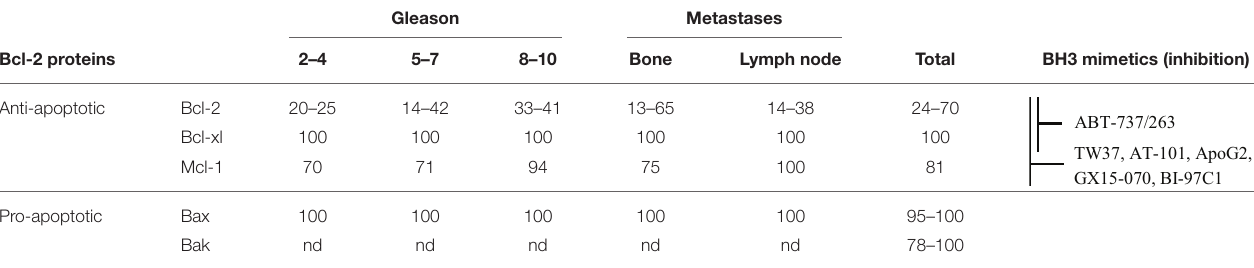
TABLE 1 | Percentage of Bcl-2 protein positive cells in prostate cancer, as determined by immunohistology in different